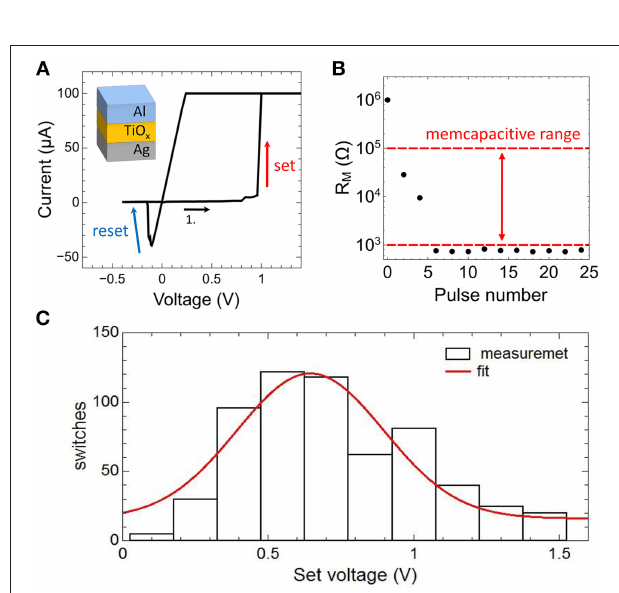
FIGURE 5 | Electrical characteristics of the memristive device: (A) Measured I-V curve of an Ag-doped TiO 2-x -based memristive device together with a sketch of the layer sequence of this cell. A current compliance of 0.1mA has been set. (B) Measured resistance variation of the device by applying 2ms voltage pulses with an amplitude of 10V. The dashed red lines show the desired memcapacitive range obtained from Figure 4B . (C) Distribution of the set voltage obtained from 620 identically voltage sweeps using a current compliance of 0.1mA. The red curve is a Gaussian data fit.